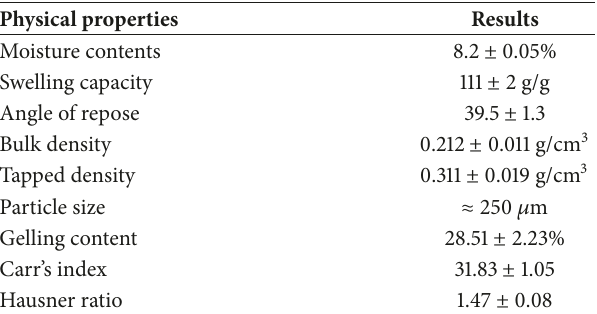
Table 2: Physical properties of